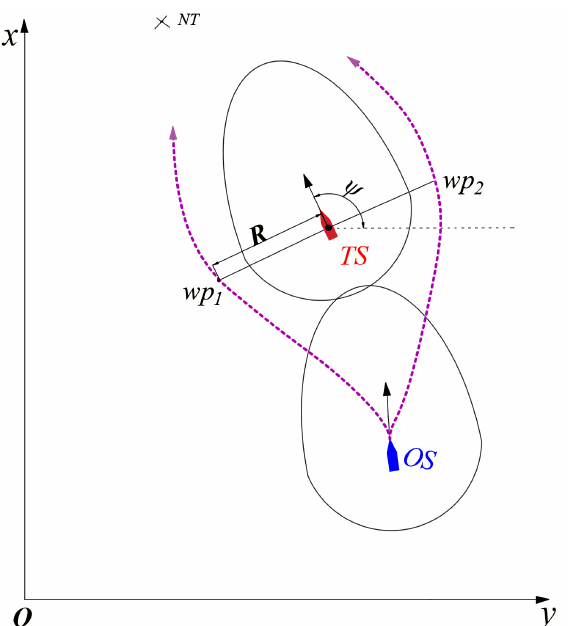
Figure 6. Determination of new way points and the local avoidance path planning